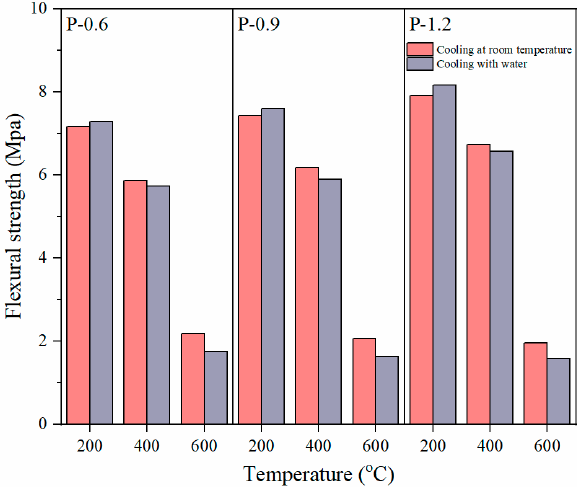
Figure 10. Flexural strength of PVA-FRCC after exposure to different temperatures.